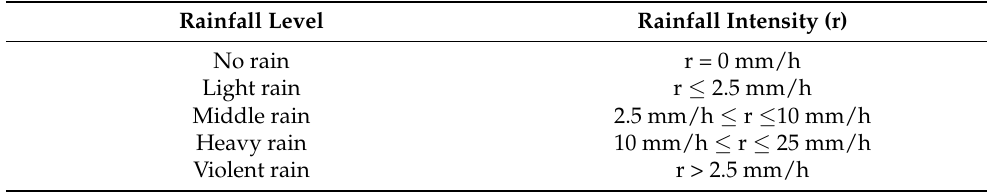
Table 2. Definitions of rainfall